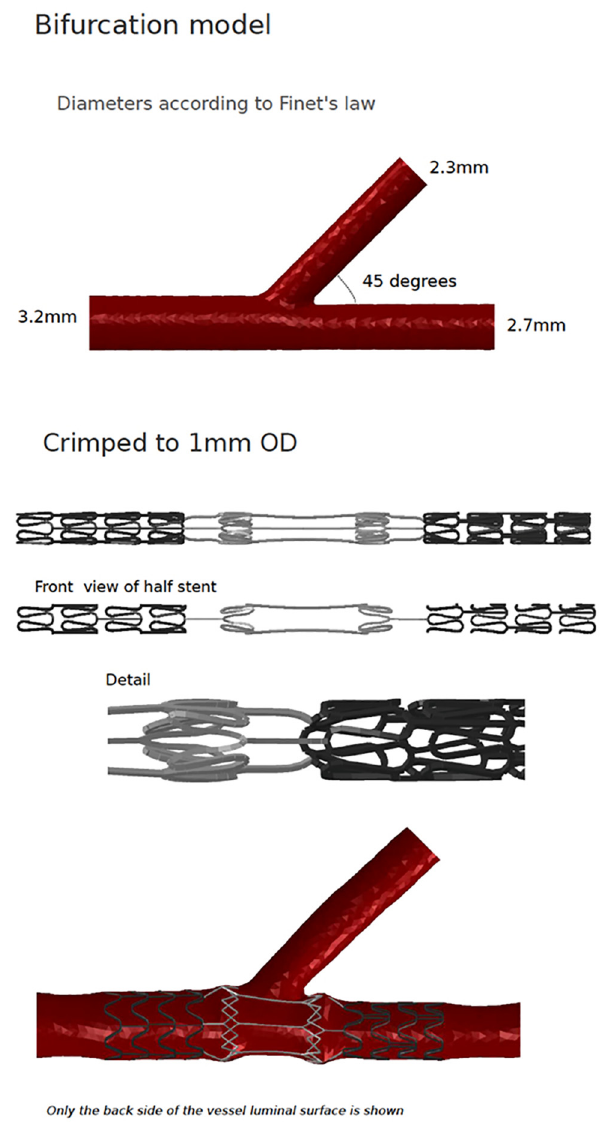
Fig 1. The creation of bifurcation model with side branch origin at 45 degrees, crimping of the stent and deployment of the stent in the bifurcation model.